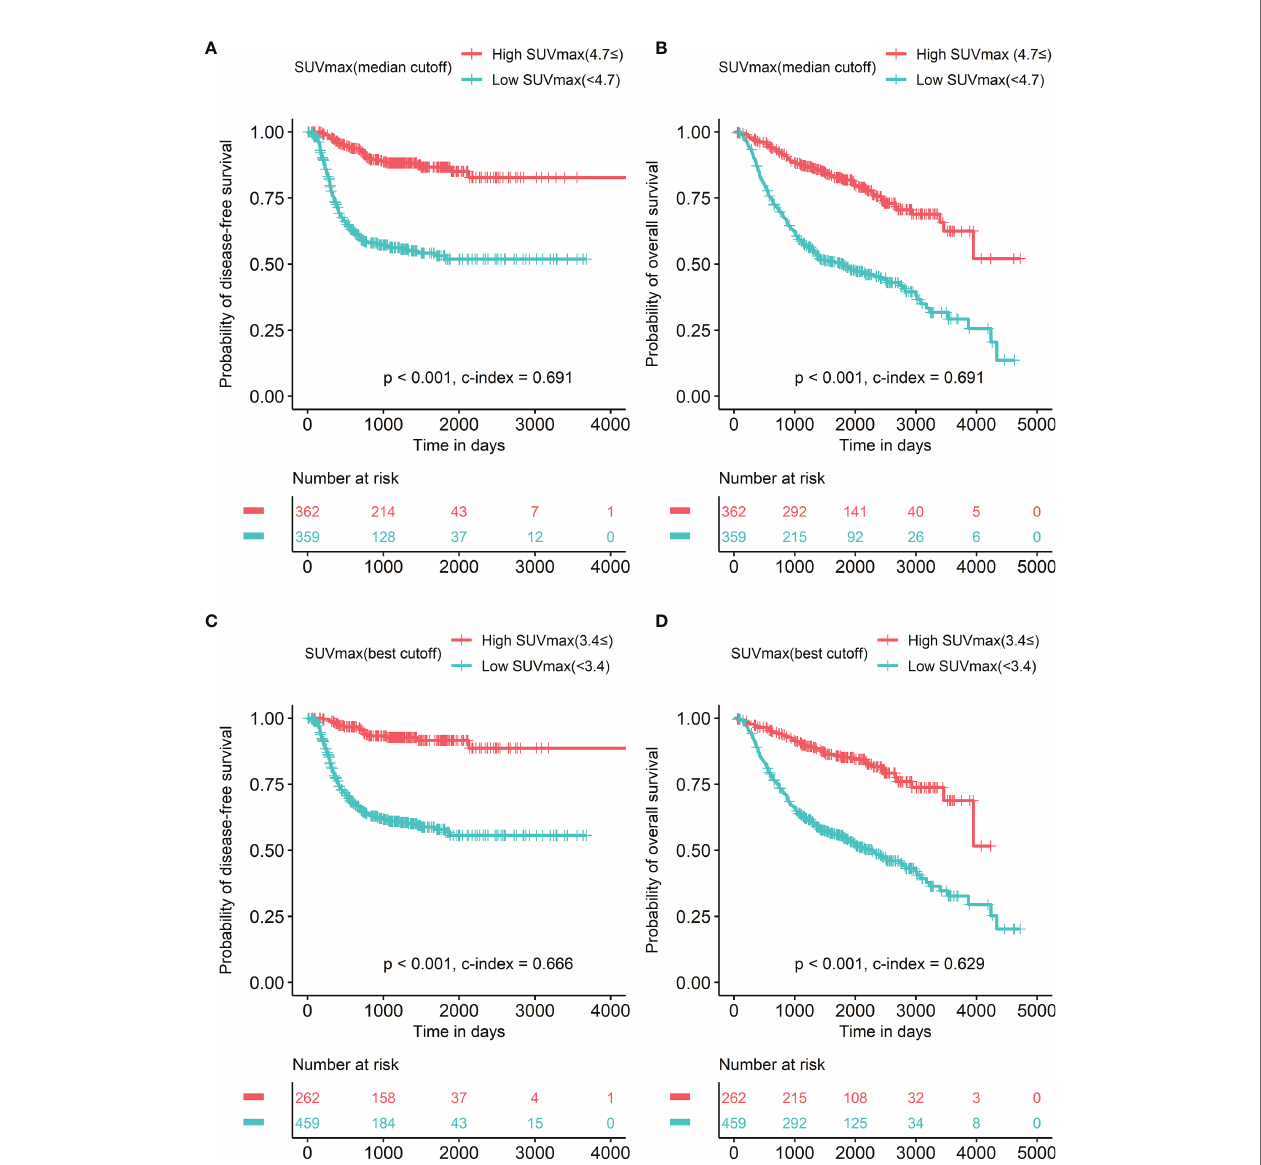
FIGURE 2 | Survival curves according to SUVmax UVmax with median cutoff was a signi fi cant prognostic factor in both disease-free survival (A) and overall survival (B) . SUVmax with the best cutoff to discriminate prognosis of overall survival most accurately in all patients showed the same results in both disease-free survival (C) and overall survival (D)